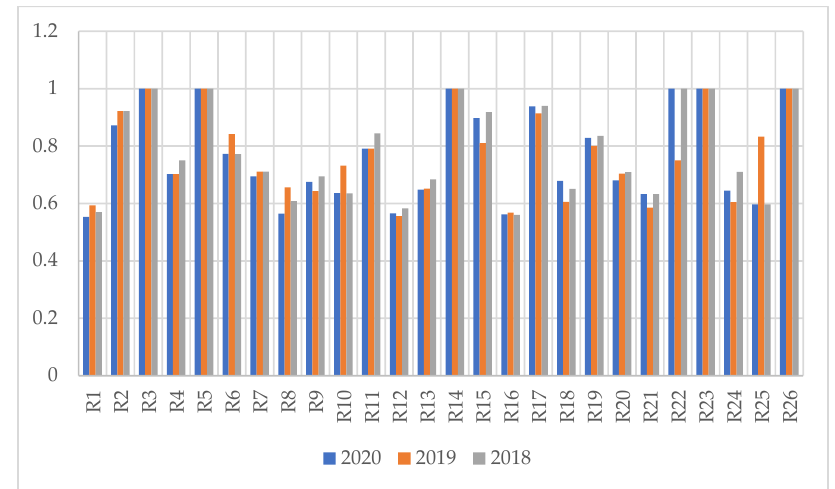
Figure 2. Regional airport efficiency. Source: Authors’ own creation. Evaluation of the results. The most significant variables of the study were runway length and number of employees. It was possible to identify the region of Antioquia where most of these small airports are located, as well as to identify the year in which efficiency is reduced in a small proportion, due to the application of incorrect public policies for air transportation in Colombia. Validation of results. A thorough analysis of the information gathered led to the cre- ation of each airport ’ s optimal degree of efficiency. After formalizing the data projection, it became clear that work needed to be undertaken, notably on the runway length variable, which, in certain circumstances, should be increased or decreased, to obtain the best de- gree of efficiency for small regional airports. It was also evident that the number of em- ployees played a very important role in raising the level of efficiency of small regional airports in Colombia. 5. Conclusions The variables analyzed were runway length, number of employees, operating cost, as well as passengers and ton of cargo. These variables were slightly correlated. Based on the literature, we assume that a BAM model with variable returns to scale is best suited to measure airport efficiency [34]. Calculations using variable returns to scale are important for economies, as small regional airports are likely to experience increasing returns to scale. Additionally, they guarantee the efficiency score ’ s invariance, allowing variables to include zero or negative values in the analysis, which is required because some airports have no goods movement [35]. Variable returns at the BAM scale are incor- porated in the restrictive convexity in the model. Given that Colombia tends to increase the number of passengers and goods trans- ported by air because of the challenges for land transportation due to bad roads and the geography of the country ’ s mountain range, it is suggested that future studies increase the number of variables considered in order to complete this study. Author Contributions: Conceptualization, D.M.M.-Q. and O.L.L.-S.; methodology, D.M.M.-Q. and O.L.L.-S.; software, D.M.M.-Q. and O.L.L.-S.; validation, D.M.M.-Q. and O.L.L.-S.; formal analysis, D.M.M.-Q. and O.L.L.-S.; investigation, D.M.M.-Q., O.L.L.-S. and J.A.J.-B.; resources, J.A.J.-B.; data curation, D.M.M.-Q., O.L.L.-S. and J.A.J.-B.; writing — original draft preparation, J.A.J.-B.; writing — review and editing, J.A.J.-B.; visualization, J.A.J.-B.; supervision, J.A.J.-B.; project administration, J.A.J.-B.; funding acquisition, J.A.J.-B. All authors have read and agreed to the published version of the manuscript.